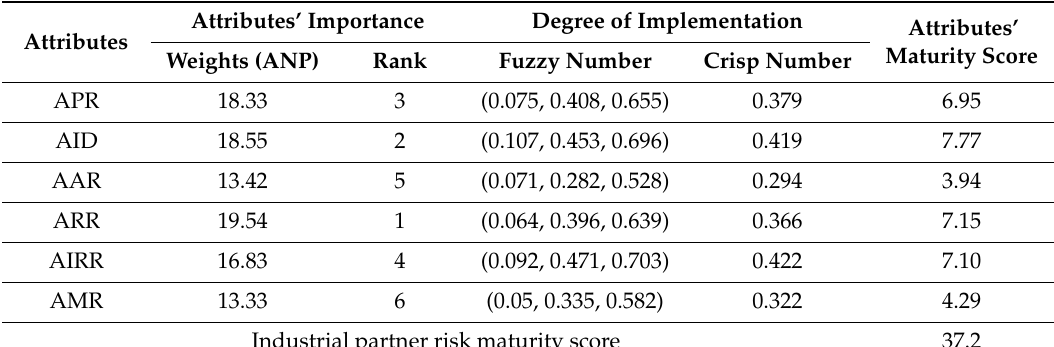
Table 12. Risk maturity score of industrial partner’s organization.